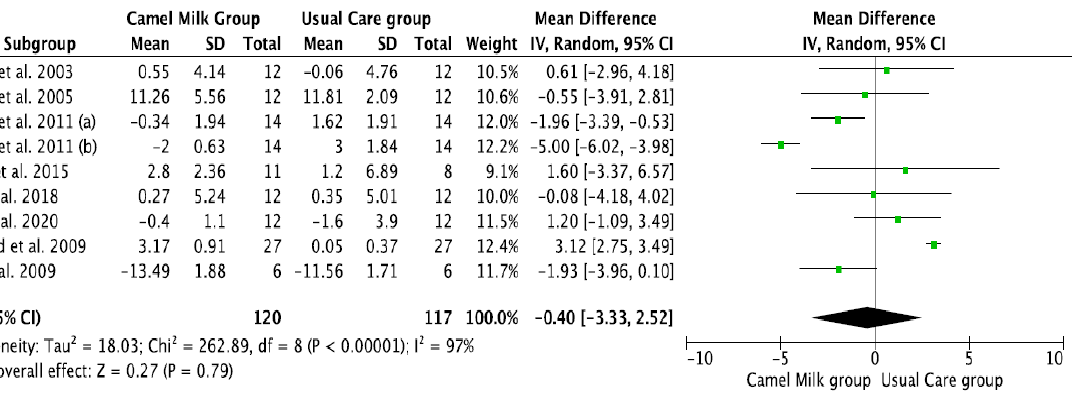
Figure 7. Forest plot for the effect of CM intake on HOMA ‐ IR. (b): difference between the two articles that are published by same author (Agrawal), same year.